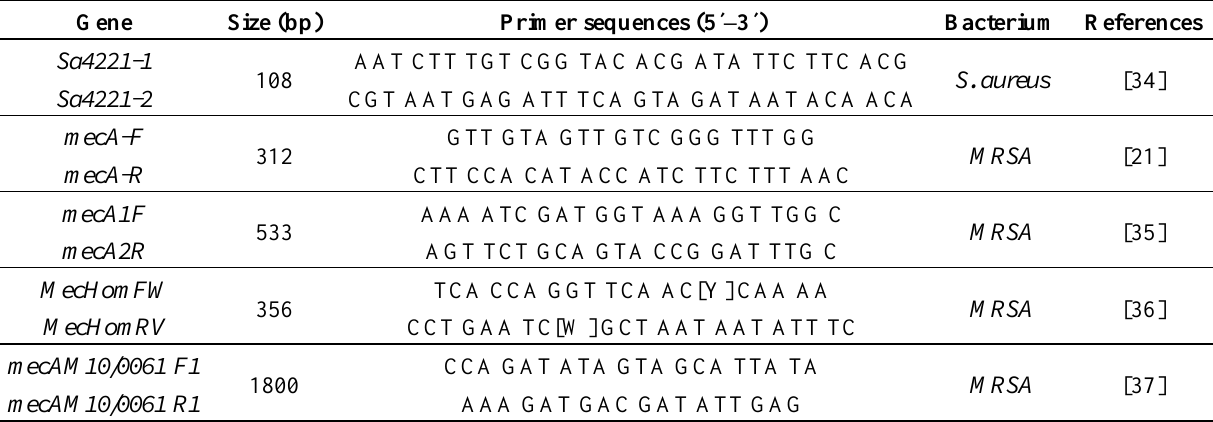
Table 1. PCR primers and their references for Staphylococcus aureus and MRSA